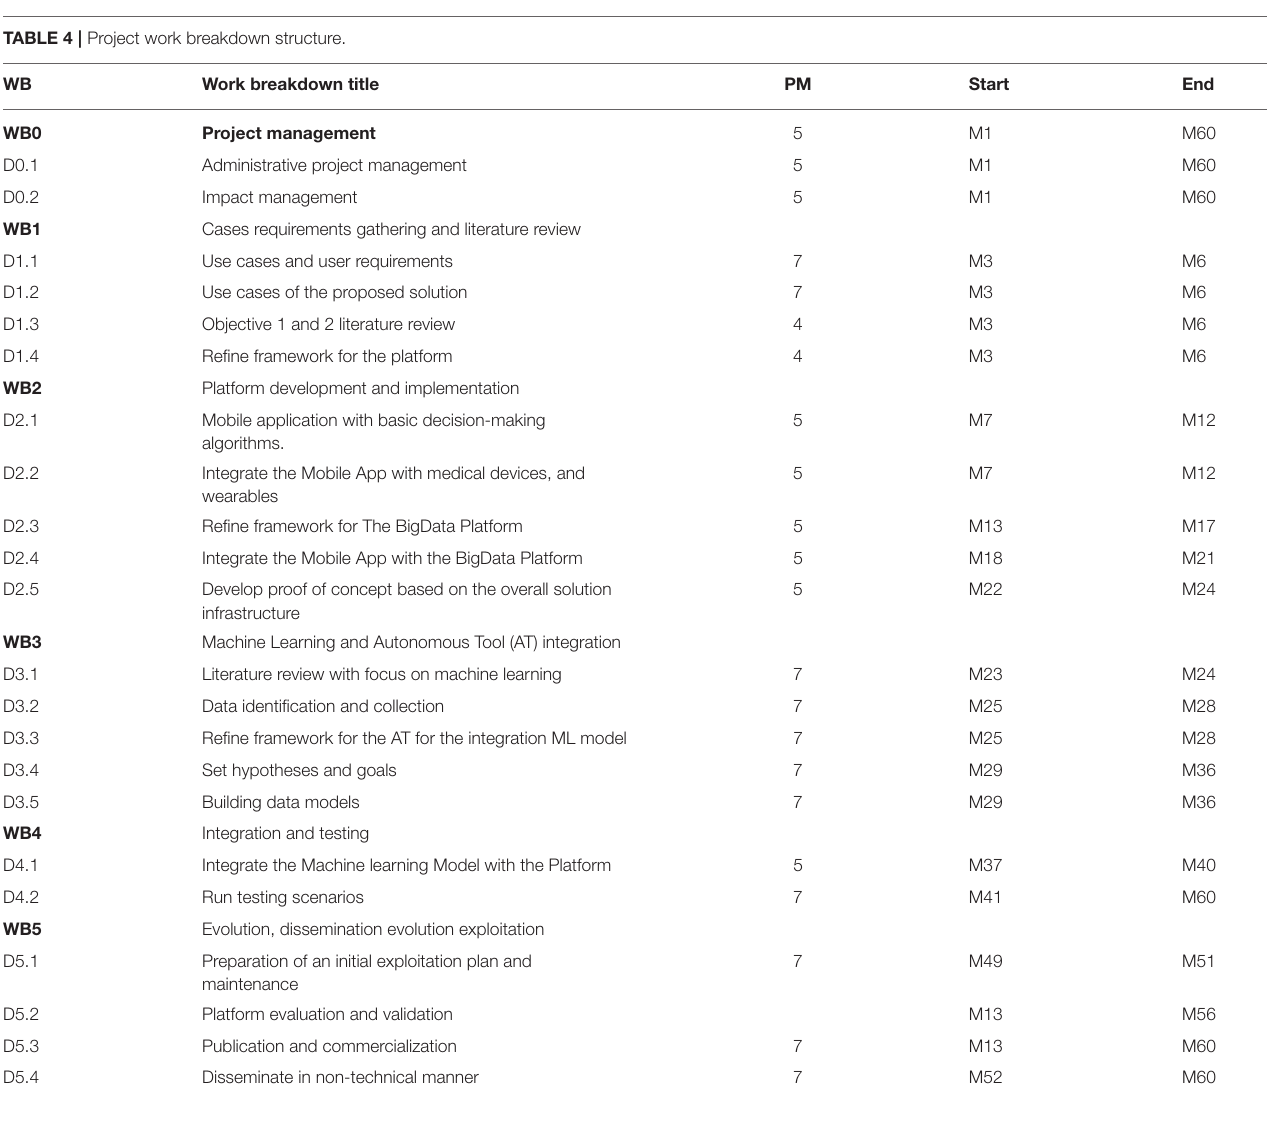
TABLE 4 | Project work breakdown